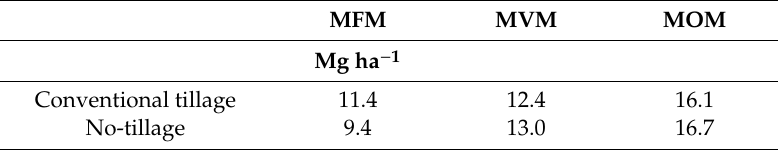
Table 2. Cumulative amount of biochar applied to the treatments in the study. MFM MVM MOM Mg ha − 1 Conventional tillage 11.4 No-tillage 9.4